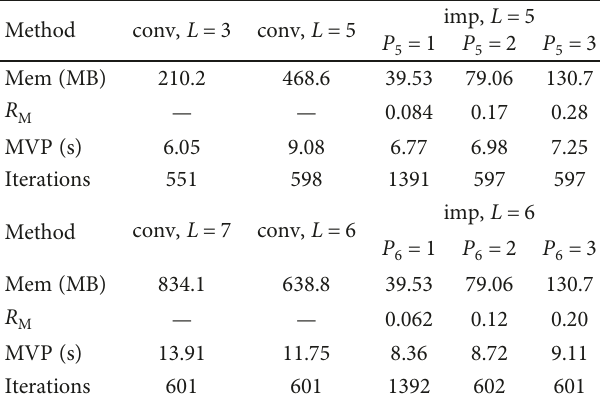
Table 1: Memory requirement by RPs and time cost per iteration versus various L and